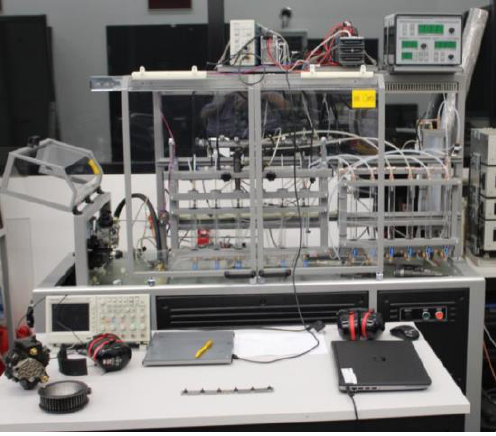
Fig. 1. Common rail system component test